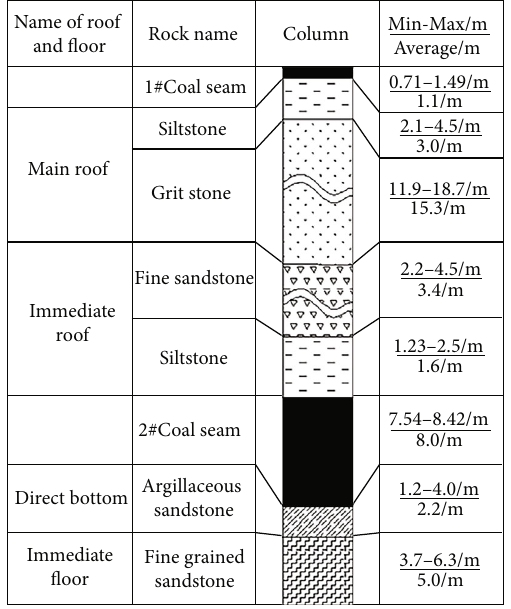
Figure 1: 130204 comprehensive column diagram of coal and strata in working